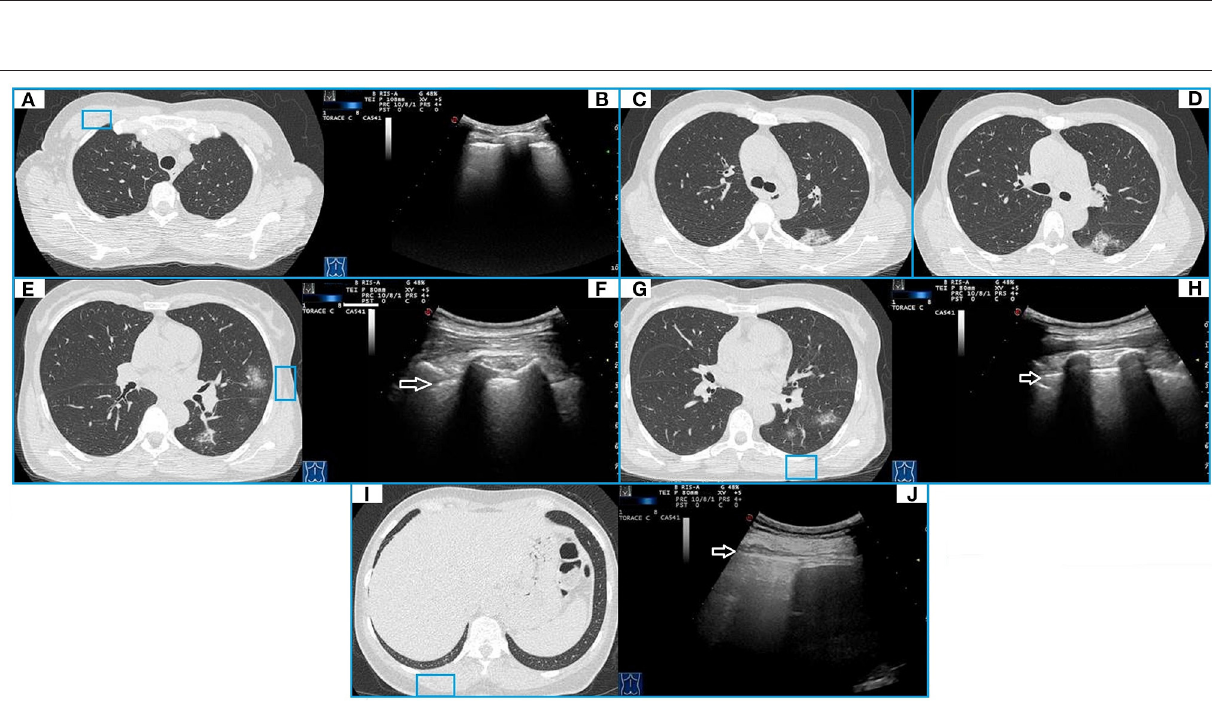
FIGURE 3 | CT and TUS findings in mild COVID-19 pneumonia. A 57-year-old female patient presenting in ED with a 1 week fever, dyspnea, cough, and fatigue. The RT-PCR assay on nasopharyngeal swab confirmed the suspect for COVID-19 pneumonia. In (A) , axial CT scan passing through the upper lobes shows a peripheral focal ground glass opacity located in the anterior parenchyma of right upper lobe and not adhering to the pleural surface. In (B) , ultrasound scan with a convex probe (6 MHz) and thoracic setting in the upper region of the chest [blue box in (A) ] shows a normal hyperechoic pleural line (white arrow) without B-lines. Axial CT scans passing through the tracheal carina [in (C) ] and the middle lung regions [in (D) ] show mixed areas of ground glass/consolidation with subpleural distribution in the left lower lobe. These lesions are located in the retroscapular area, resulting in being not visible on ultrasound scans. Axial CT scans passing through the middle lung regions [in (E) ] and the lower lobes [in (G) ] show rounded focal ground glass opacities with central distribution in the lingula and the left lower lobe. In (F,H) , ultrasound scans with a convex probe (6 MHz) and thoracic setting, corresponding to the blue boxes in the respective CT scans, show a normal hyperechoic pleural line without B-lines (white arrow). In (I) , axial CT scan passing through the basal lung regions shows no significant lesions. In (J) , ultrasound scan with a convex probe (6 MHz) and thoracic setting, corresponding to the blue box in the respective CT scan, shows a normal hyperechoic pleural line (white arrow) near the correspondent right posterior costofrenic